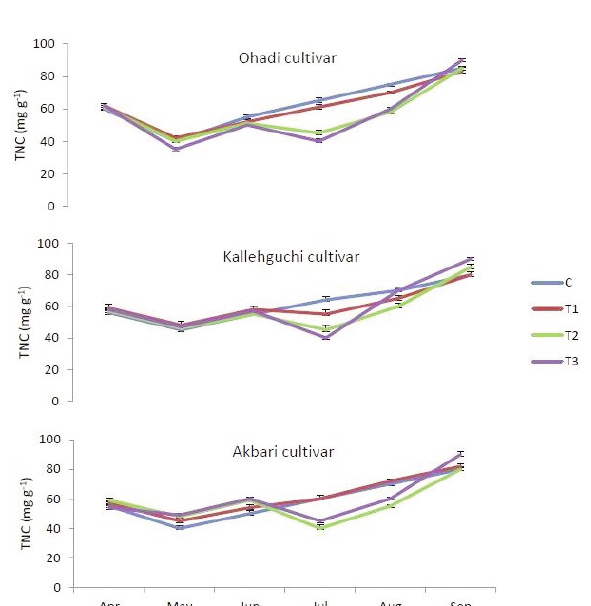
Fig. 2 - Interaction of stage of brassinostroides application and cultivar on activities of some antioxidant enzyme of pistachio in the “off” year. C= Control, T1= Bud swelling phase, T2= two weeks after full bloom, T3= T1 and T2. Different letters within a row indicate significant differences by Duncan’s multiple range tests at P<0.05.